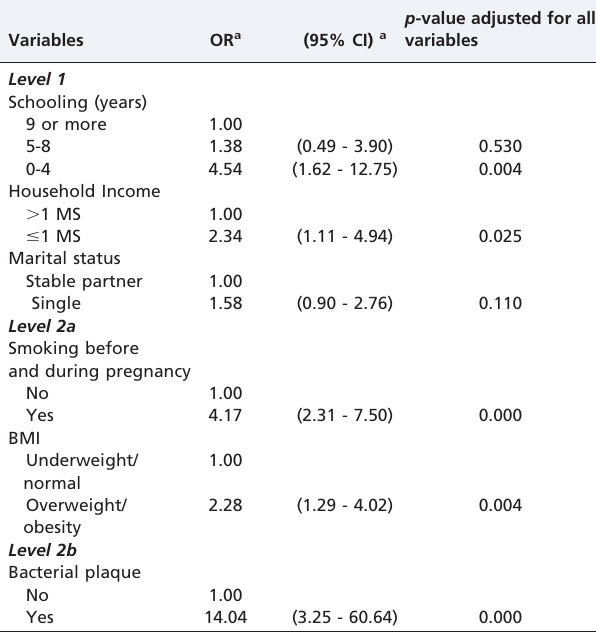
Table 5 - Final multivariate model of periodontitis- associated risk factors in pregnant women from Recife, Brazil, 2008.